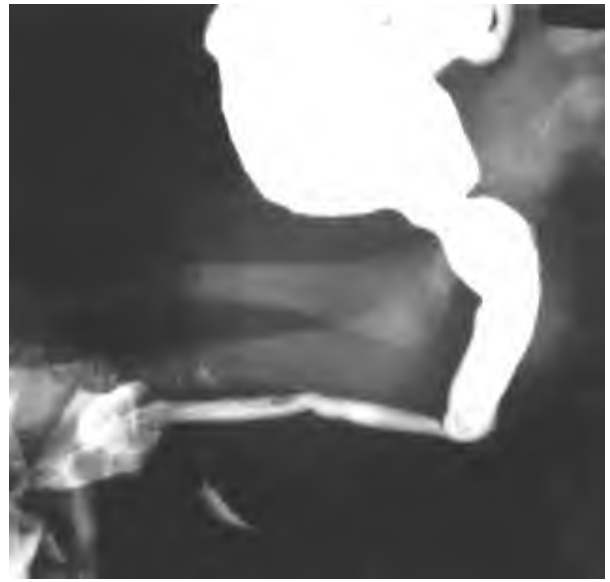
FIGURE 1. Voiding cystourethrogram demonstrating posterior urethral valves and dilation of proximal